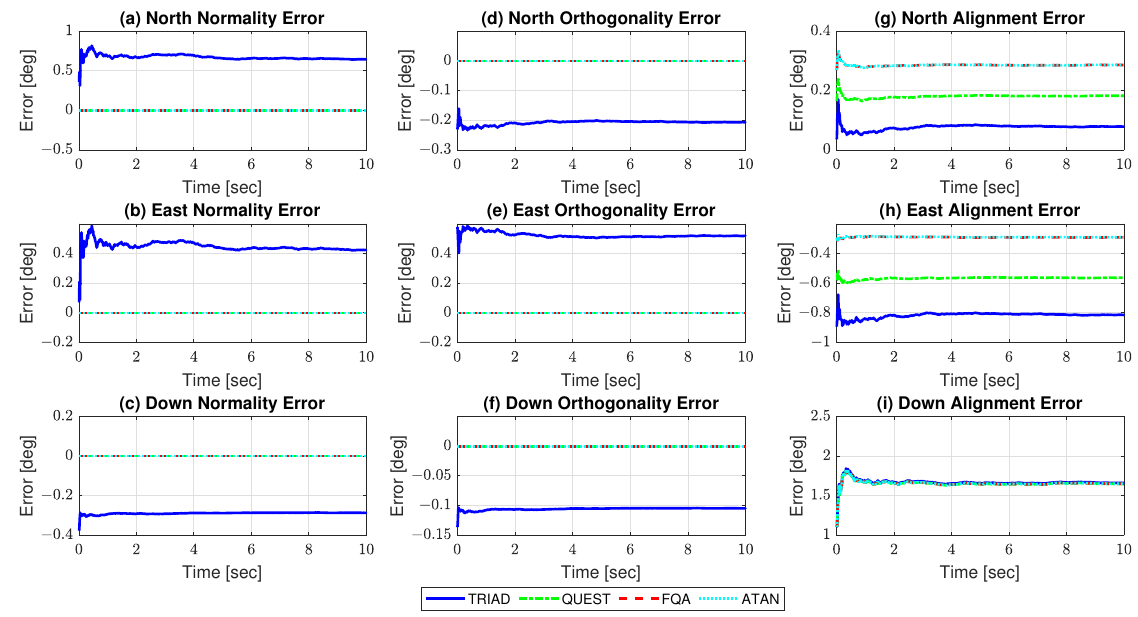
Figure 2. Estimated Direction Cosine Matrices (DCM) residual errors in simulated test. Table 1. Predicted DCM normality, orthogonality, and alignment errors in simulated